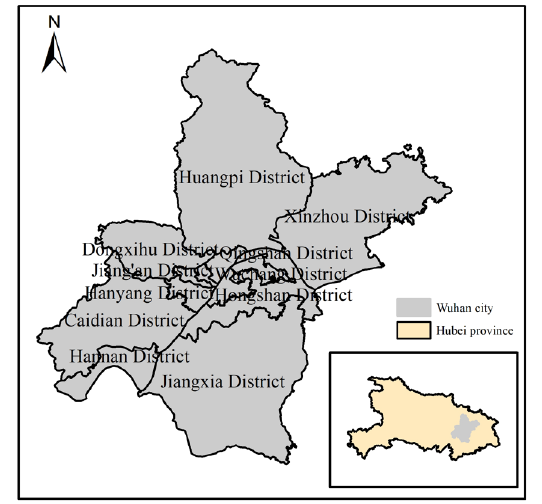
Figure 1 . The location of the study area.